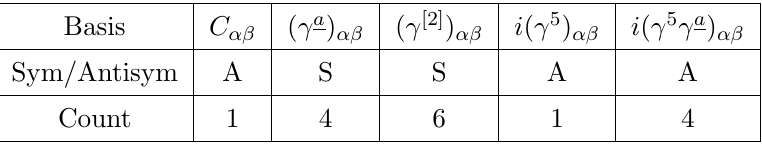
Table 3 . Summary of 4D basis: all of these are 4 (cid:2) 4 real